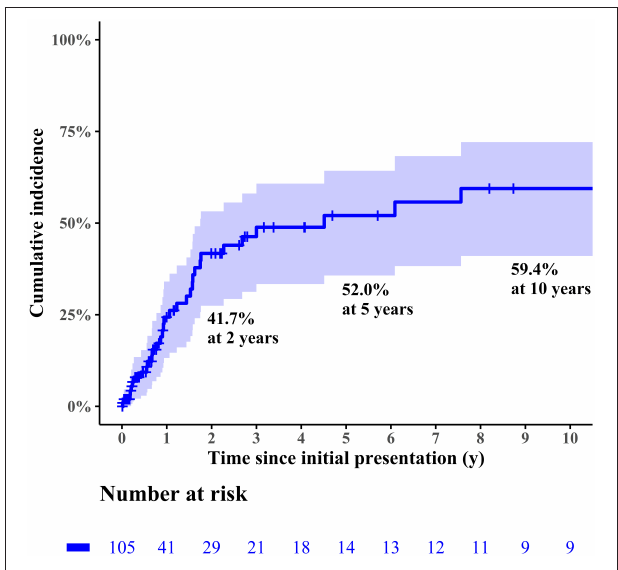
FIGURE 4 | Cumulative incidence of functional recovery in the entire